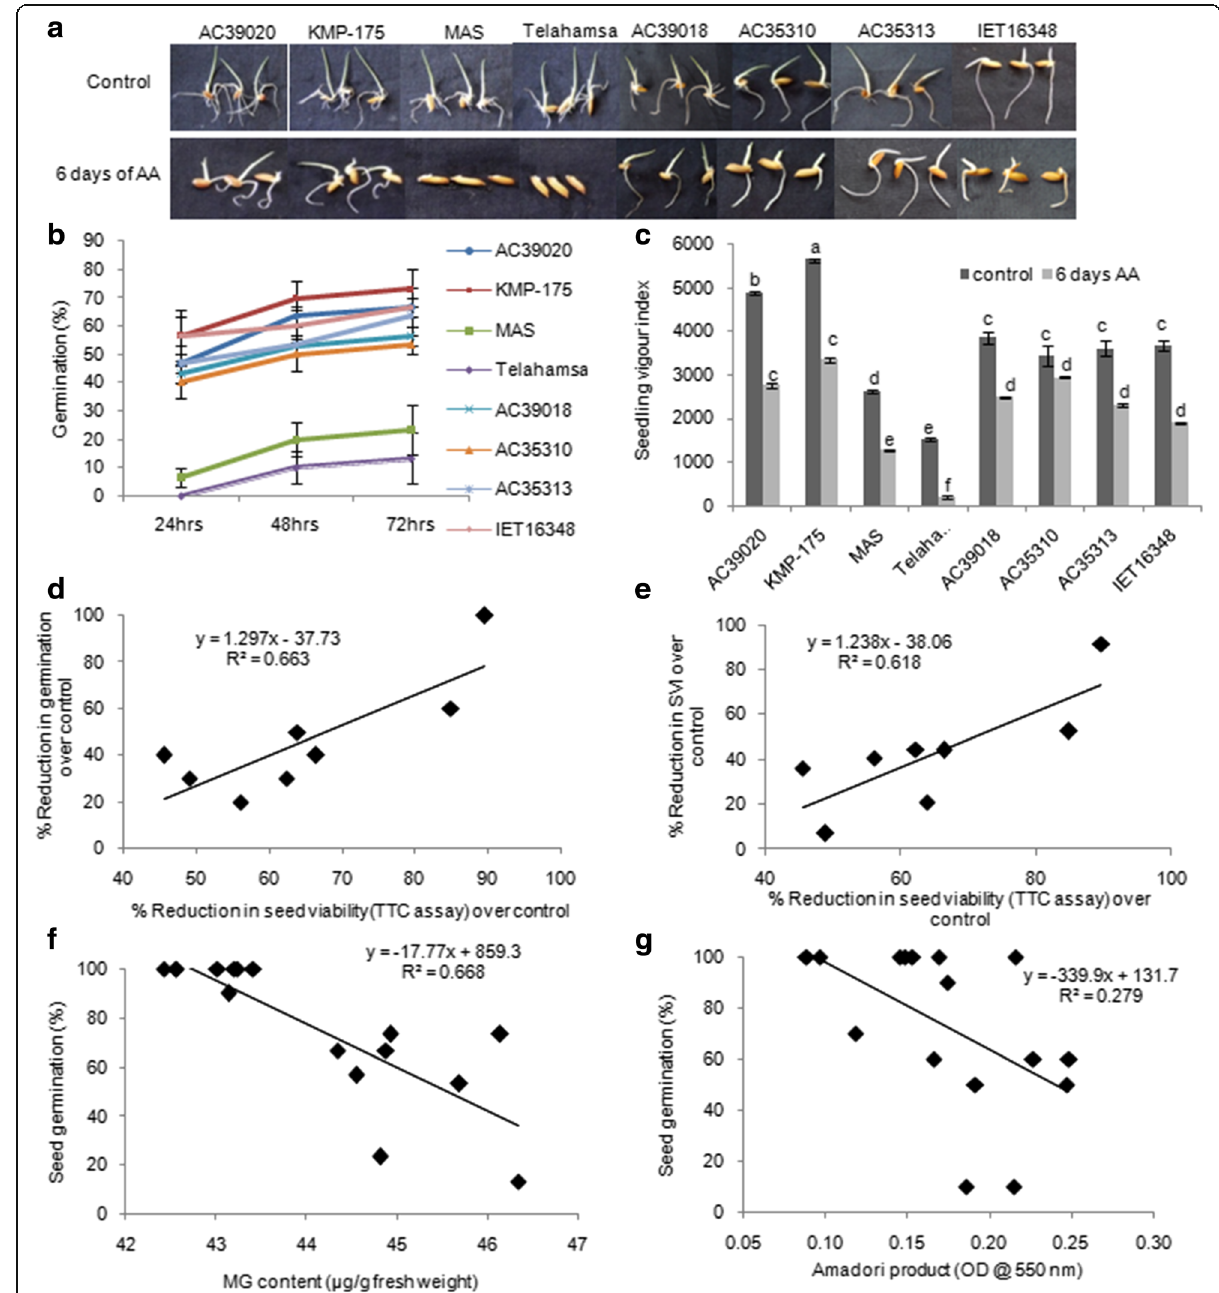
Fig. 2 Accumulation of reactive cytotoxic compounds affects seed viability, germination and seedling vigour under ageing treatments. a Photograph showing germination and seedling growth of rice after accelerated ageing treatment, b Variability in germination with time in aged and non-aged seeds ( n = 50). c Seedling vigour index (SVI) in control and aged seeds (Same Alphabets indicate non-significant at p = < 0.05). d Relationship between seed viability and seed germination and e Relationship between seed viability and seedling vigour index in rice, f Relationship between MG content and seed germination and g Relationship between Amadori products and seed